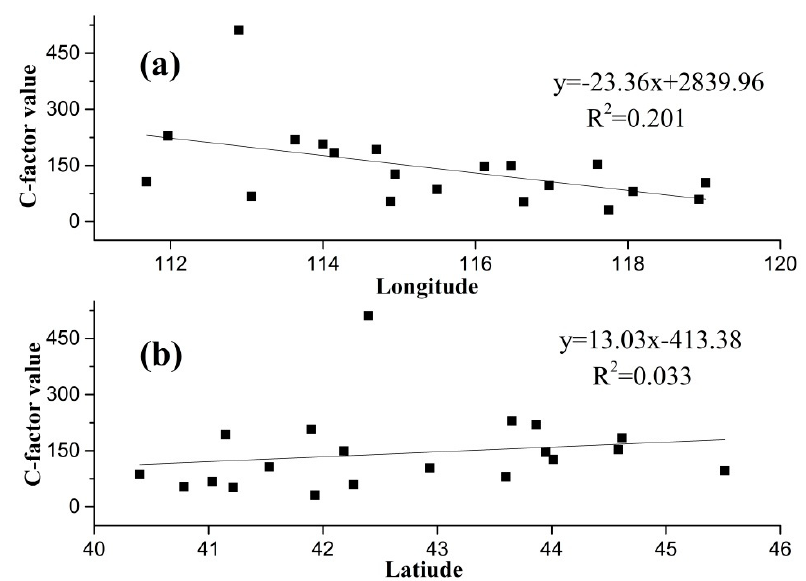
Figure 3. The relationship between ( a ) longitude, ( b ) latitude and annual C-factor value.